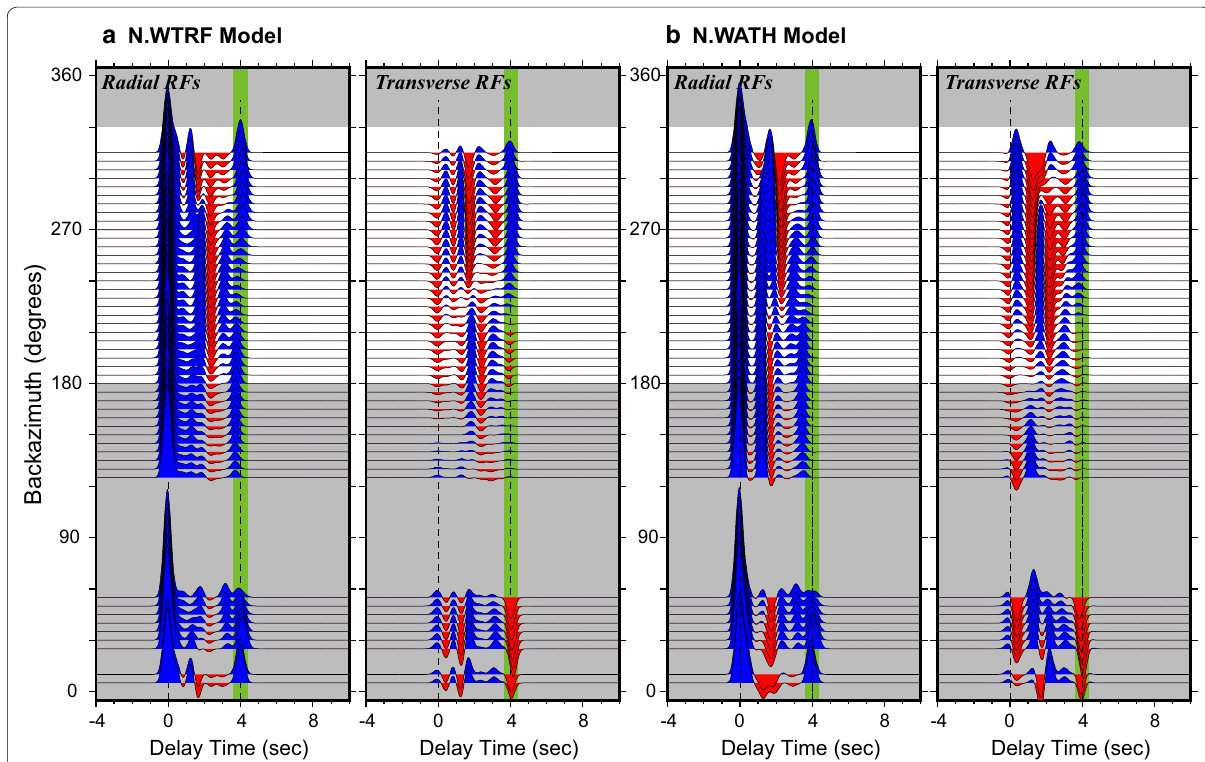
Fig. 5 Synthetic receiver functions based on the model shown in Table 1. Synthetic receiver functions calculated by using the N.WTRF model ( a ) and the N.WATH model ( b ) shown in Table 1. Representation is the same as Fig.